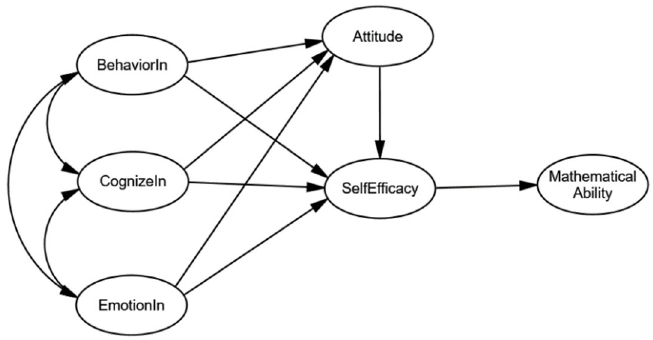
Figure 1. Conceptual diagram of the model.